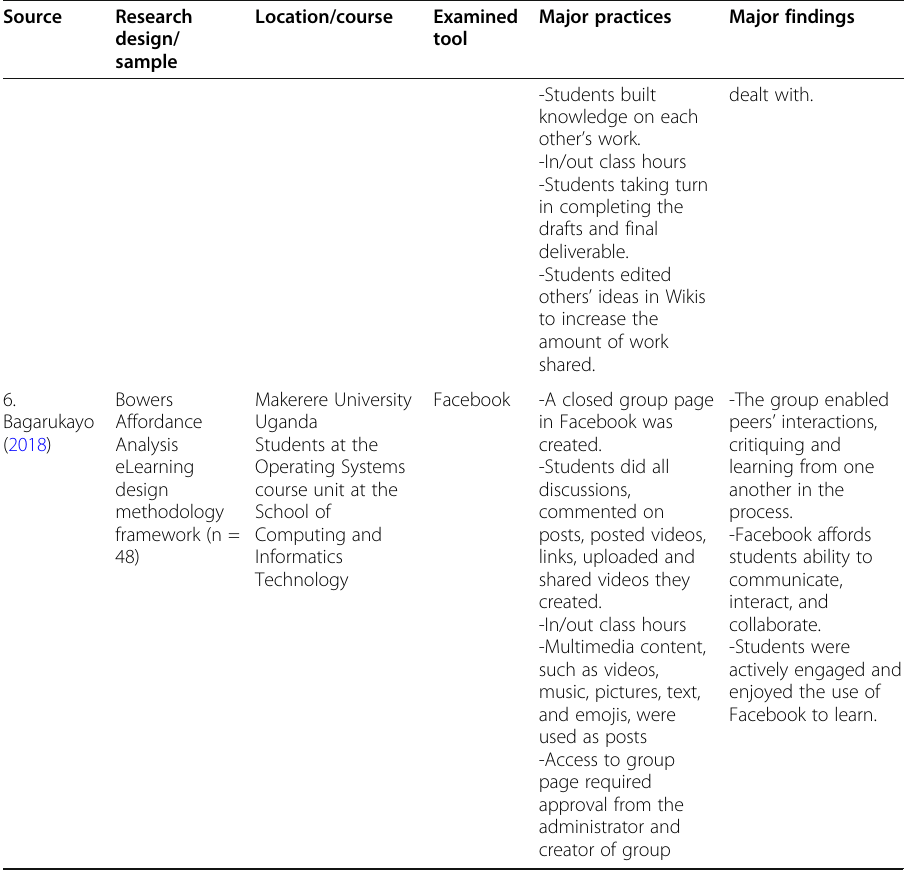
Table 4 The analysis of sources included in the integrative review